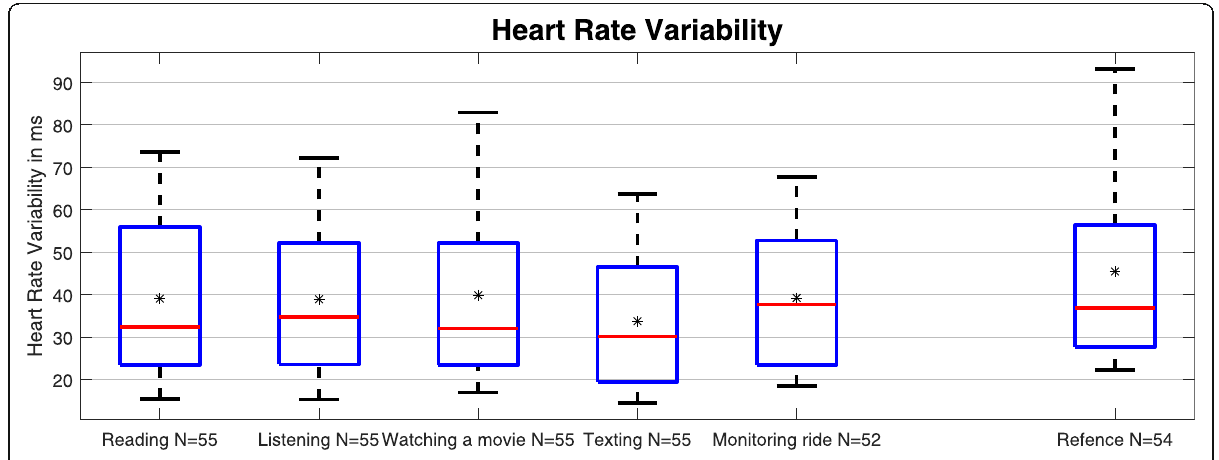
Fig. 6 Boxplot representation HRV depending on the examined NDRT in